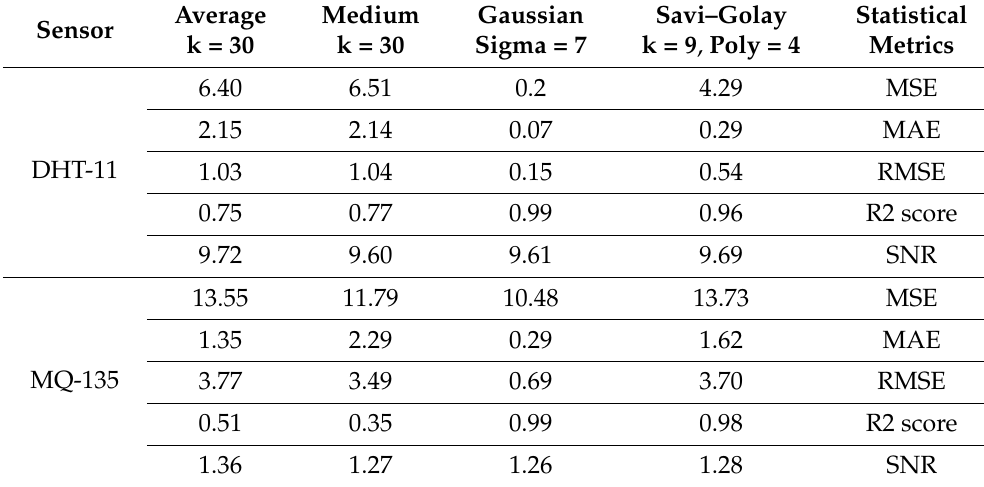
Figure 6. Smoothing graphical analysis in the proposed sensor taxonomy. ( — ) Original samples ( — ) Average filter. ( — ) Medium filter. ( — ) Gaussian filter. ( — ) Savi–Golay filter. ( a ) DHT-22 sensor. ( b ) MQ-135 sensor. Table 5. Digital pulse-train sensors’ statistical